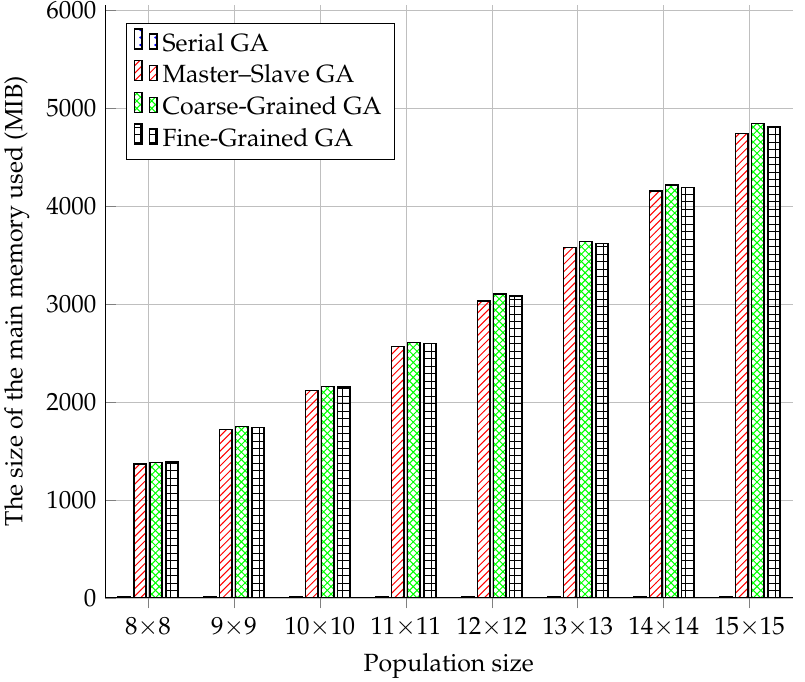
Figure 7. Comparison of GA models in main memory